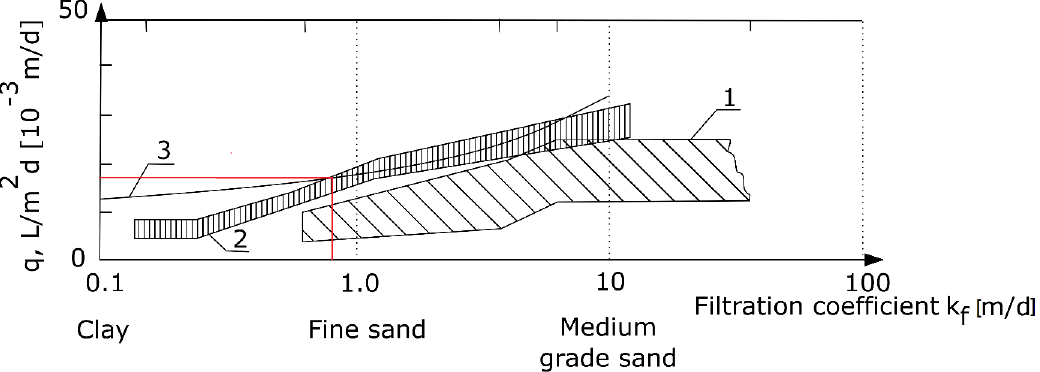
Figure 5. Permissible hydraulic loading of soil with treated wastewater q, based on (1) Polish technical guidelines for the design of infiltration drains and sand filters from 1971, calculated in accordance with a correction by Błażejewski (2003) [32], (2) French standard DTU 64.1 [33], (3) Laak (1986) [34].